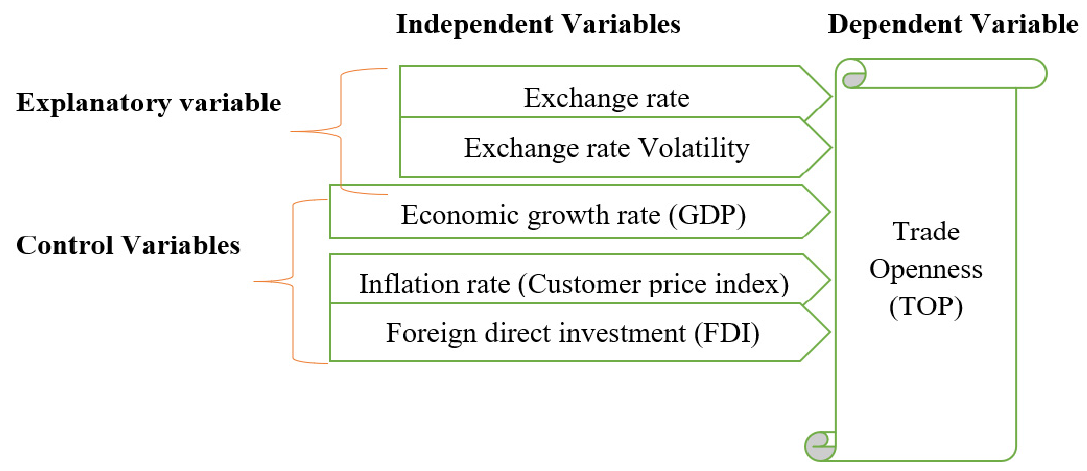
Figure 1. Conceptual framework elaborated by the authors.